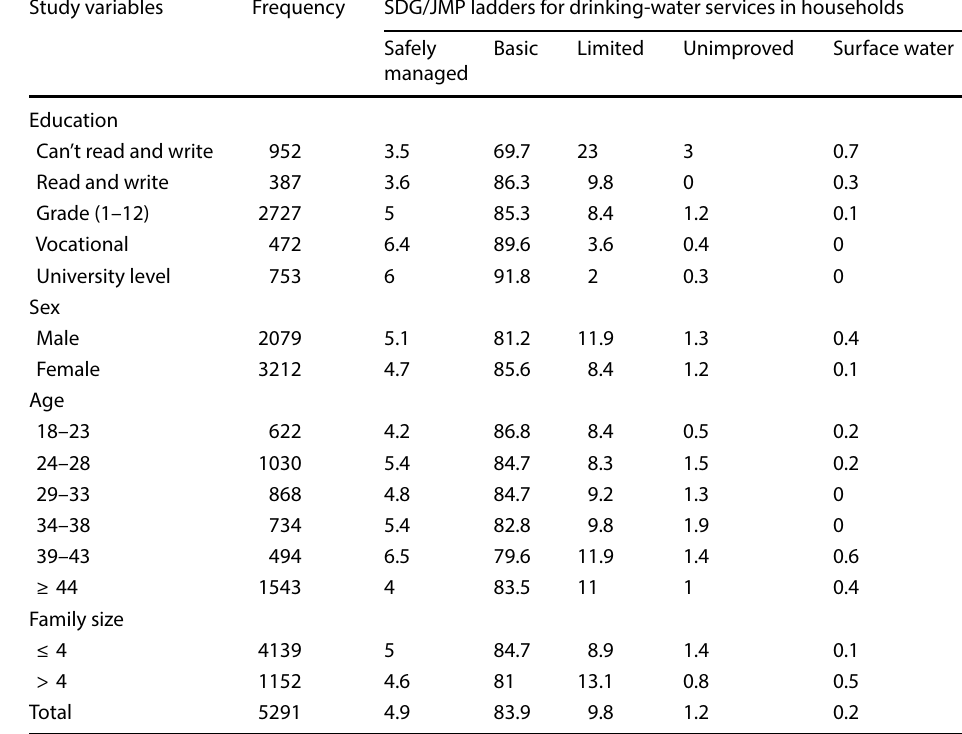
Table 1 Percentage of ladders for drinking-water services of households by sociodemographic characteristics of